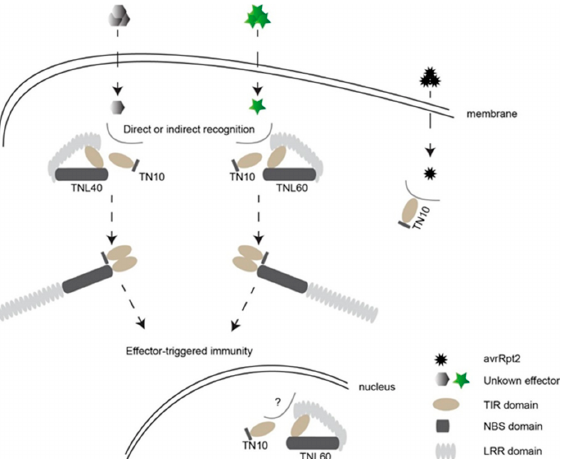
Figure 7. A possible model summarizing the function of TNL40, TNL60, and TN10 proteins in plant immunity. In the resting cell, TNL40 and TNL60 are kept in inactive states through the interaction between their domains. When plants were attacked by pathogens, TN10 interacted with TNL40 or TNL60 and resulted in the changes of the conformation of TNL proteins followed by the activation of effector-triggered immunity (ETI) responses. TNL40, TNL60, and TN10 may also function as accessory components in signal transduction during defense responses. In summary, our results here showed that TNL40 , TNL60 , and TN10 were located in the largest TN-TNL gene cluster in a head-to-head genomic arrangement. Transient ex- pression of the TIR domains of TNL40 and TNL60 triggered cell death in N. tabacum